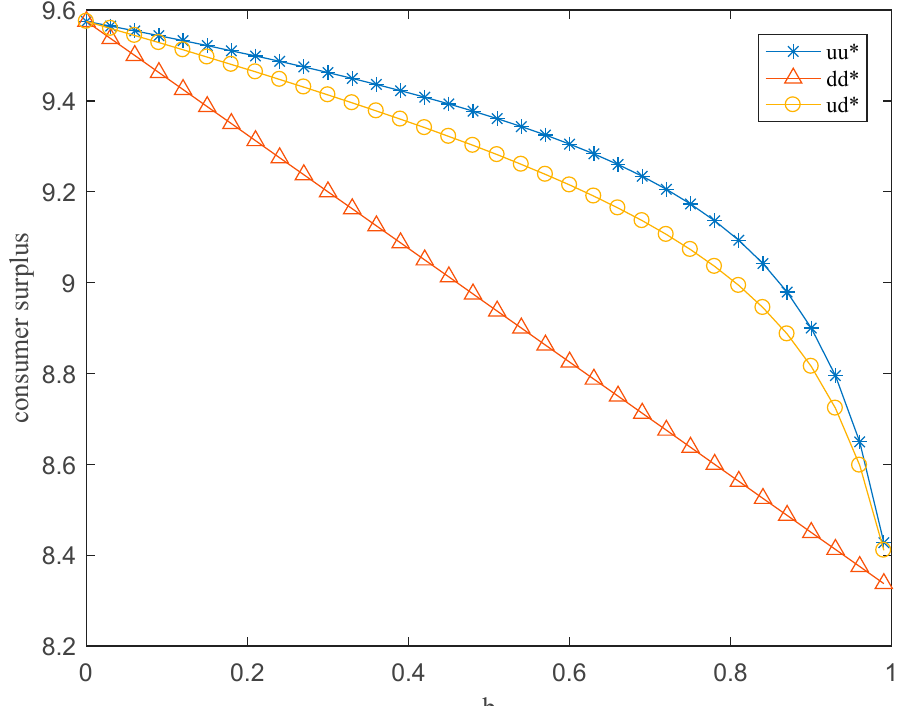
Figure 1. The total consumer surplus under different situations.